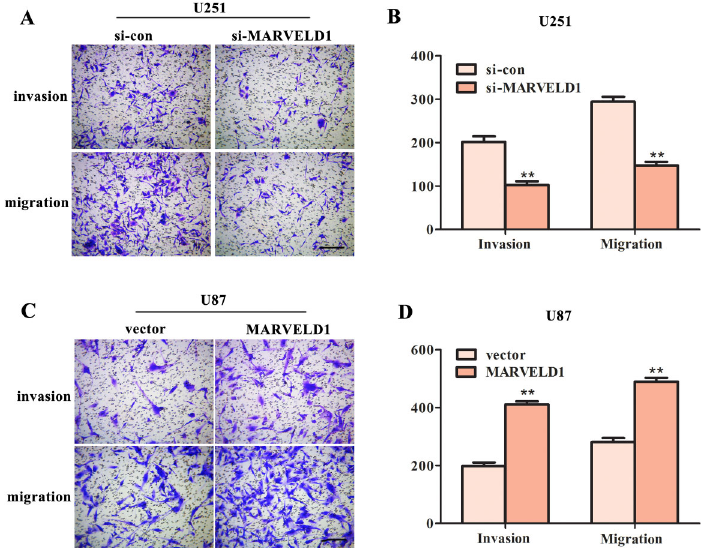
Figure 5. A and B , Transwell assay was carried out to measure the invasive and migratory abilities of U251 cells transfected with si-MARVELD1. **P o 0.01 vs si-con group. C and D , Invasion and migration of U87 cells transfected with pcDNA3.1-MARVELD1 were detected using Transwell assay. Magni fi cation bars: 200 m m. Data are reported as means ± SD. **P o 0.01 vs vector group (Student ’ s t -test).